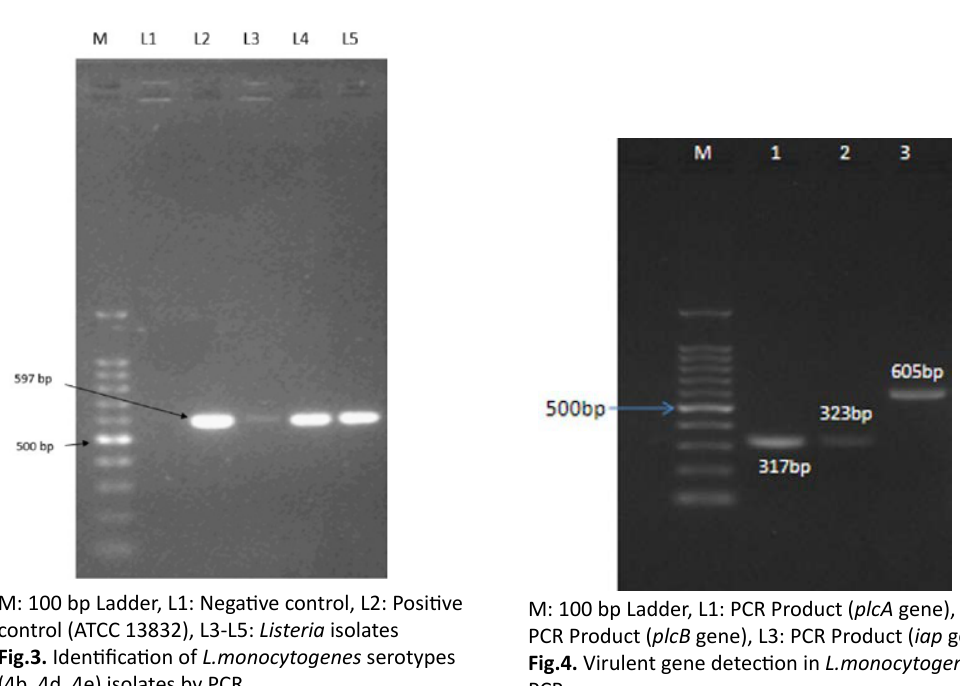
Fig.2. Identification of L.monocytogenes serotypes Fig.1. Identification of L. monocytogenes by PCR